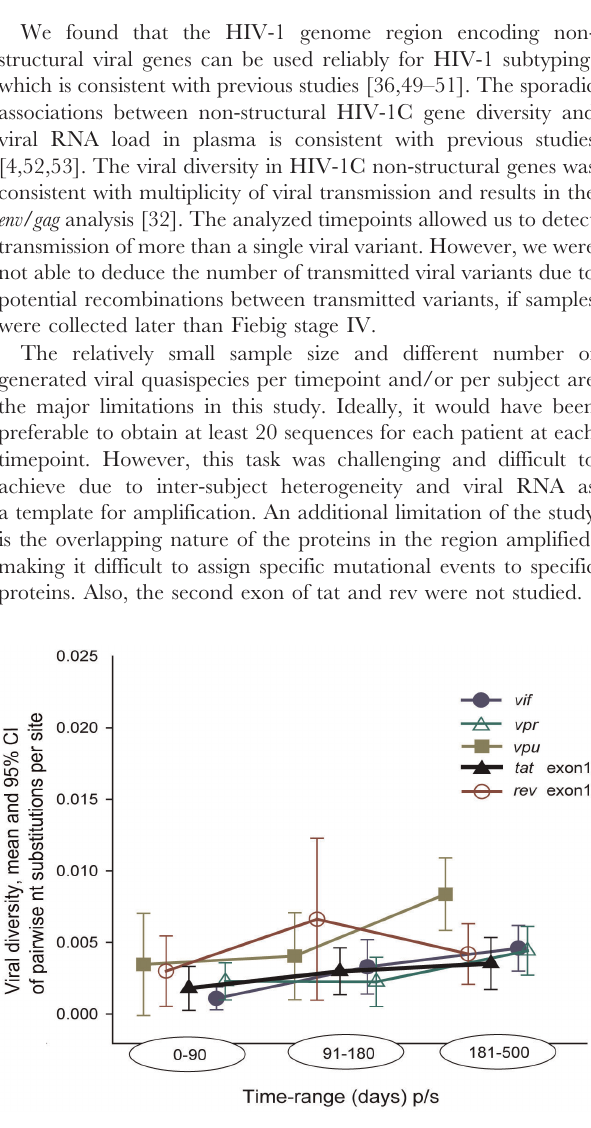
Figure S3 Viremics Analysis; Kimura 2-parameter overall mean exon1 and rev exon1 comparing two groups (high viremics –